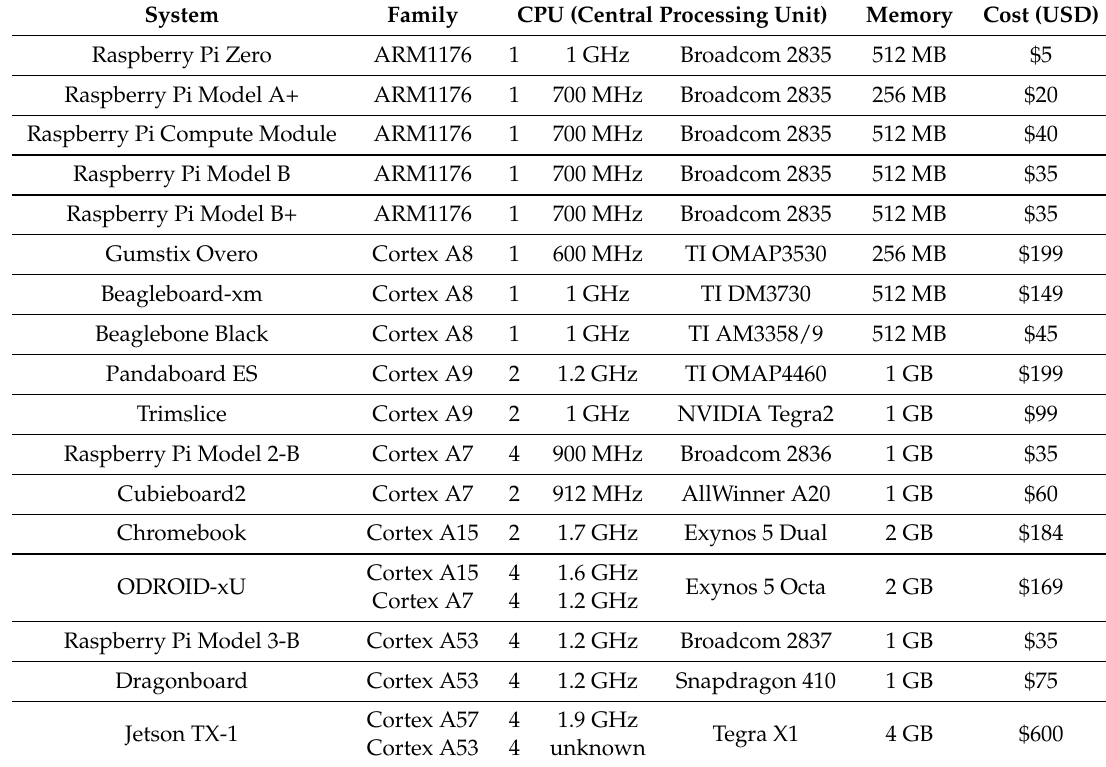
Table 1. Overview of the ARM systems examined in this work. Cost is given in U.S. dollars at the time of purchase in late 2015 or early 2016. More details can be found in Appendix